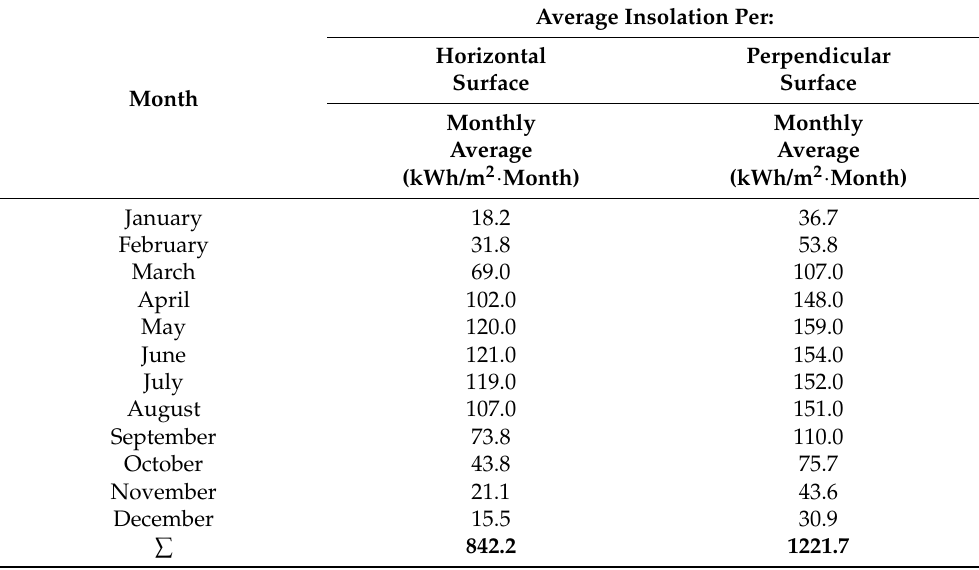
Figure 4. Comparison of insolation on horizontal and perpendicular surfaces to the sun’s rays (according to [74–76], based on [77]). Table 2. The insolation on horizontal and perpendicular surfaces to the sun’s rays on the SBG’s area (according to [74–76], based on